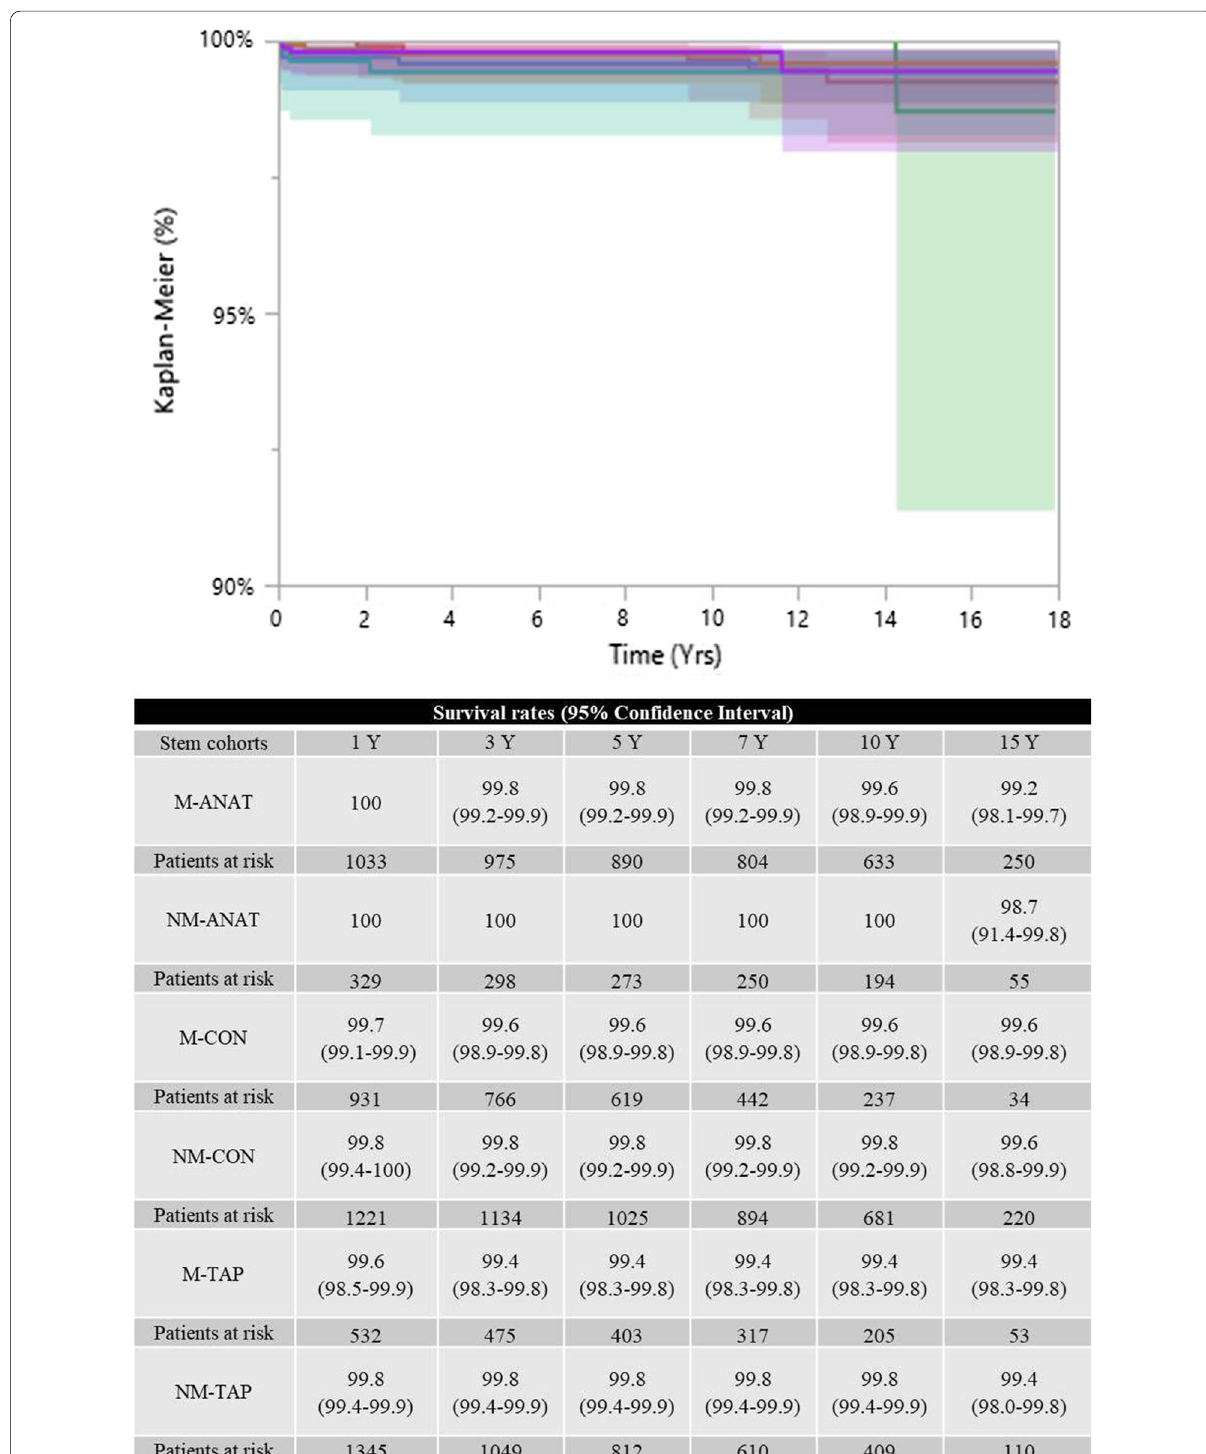
Fig. 3 The six survival rates were similar when the endpoint was revision due to stem aseptic loosening ( p red line; NM-ANAT: green line; M-CON: blue line; NM-CON: orange line; M-TAP: cyan line; NM-TAP: violet